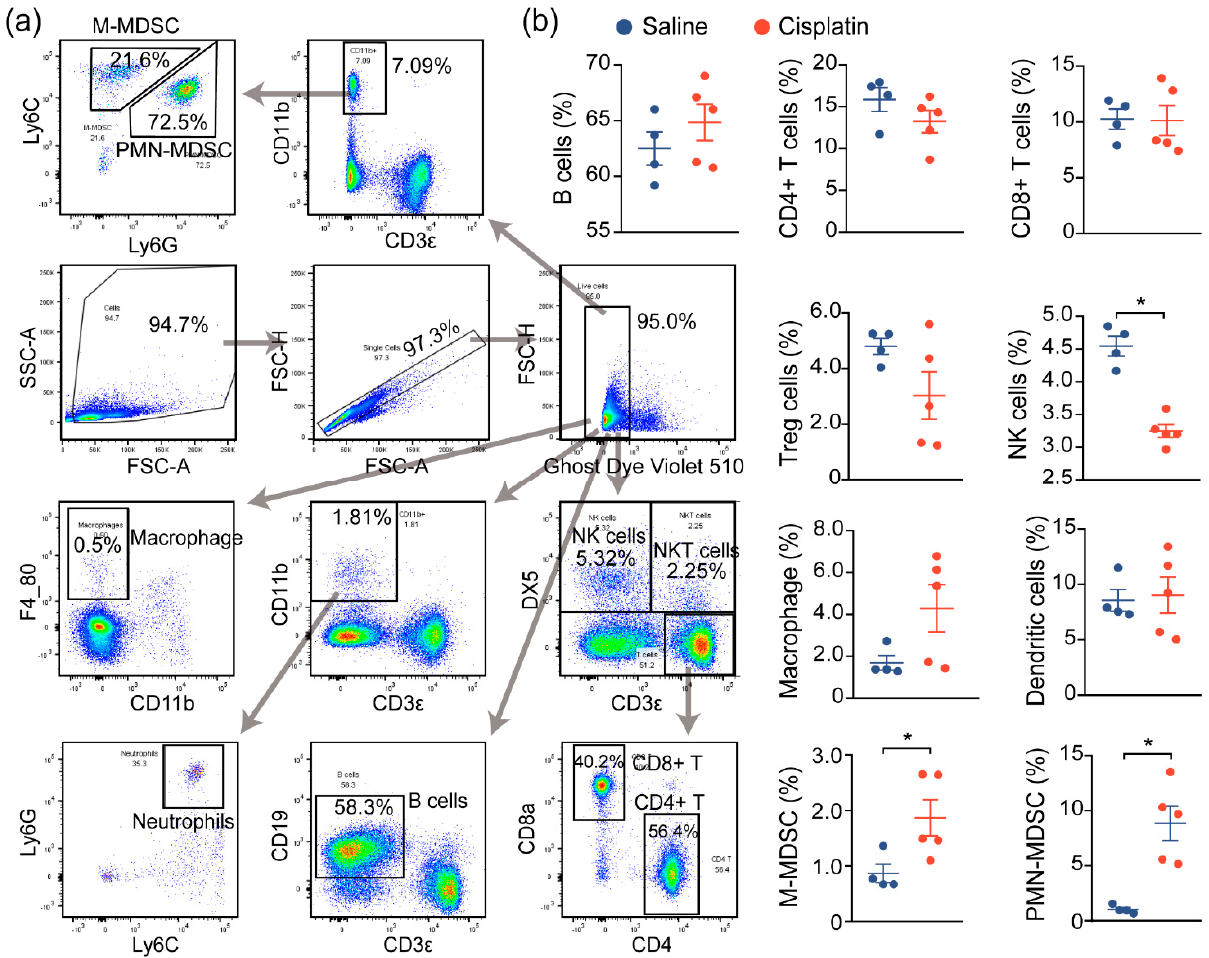
Figure 2. AKI mice exhibit an imbalanced immune response. ( a ) Gating strategy for immune cell profiling of mice in Figure 1. Single cell suspension of immune cells from spleens of mice were prepared and labeled with the indicated antibodies and dyes. Data were acquired by flow cytometry and analyzed using Flowjo. ( b ) Analysis of splenic immune cells in mice administered with saline ( n = 4), or 30 mg/kg cisplatin ( n = 5, * p < 0.05)